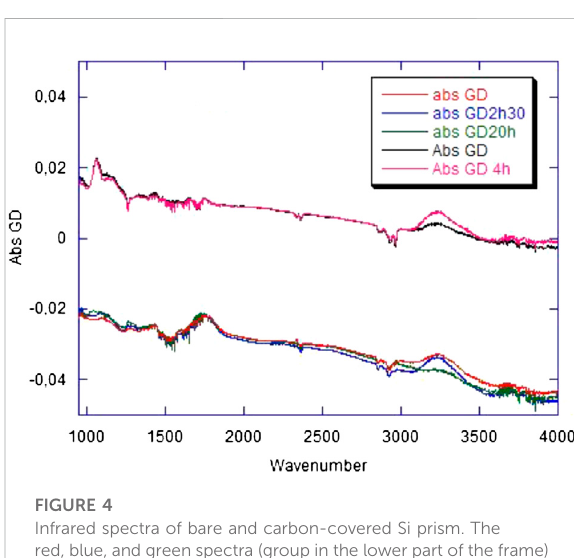
FIGURE 4 Infrared spectra of bare and carbon-covered Si prism. The red, blue, and green spectra (group in the lower part of the frame) correspondtotheSiprismcoveredwithacontinuouscarbonlayer to simulate a classic Quantifoil grid; they have been recorded 1 h, 2 h 30 min, and 20 h after glow discharge, respectively. The black and pink spectra (upper part of the frame) correspond to the bare Si prism. Spectra have been recorded 1 and 4 h after glow discharge. All spectra have been recorded for an s-polarized infrared beam. In each case, the reference spectrum has been recorded prior to the GD treatment. The spectra are plotted as absorbances computed using a natural logarithm and correspond to 14 useful re fl ections in internal-re fl ection